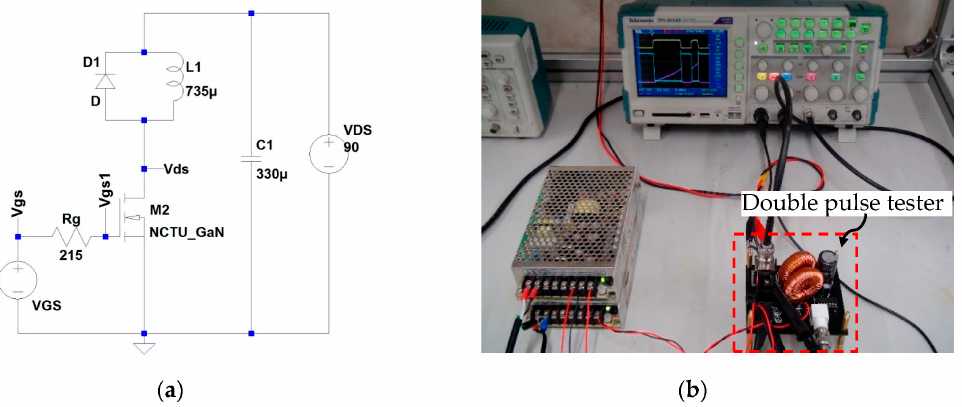
Figure 10. Double-pulse test circuit ( a ) in the LTspice program for simulation and ( b ) used in the